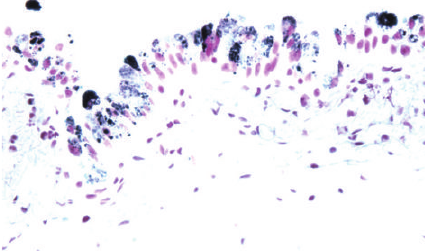
Figure 2: Fontana Masson stain for melanin: standard resolution. The pigments stain brown by Fontana stain which is consistent with melanin. Taken from Jin et al. [52].